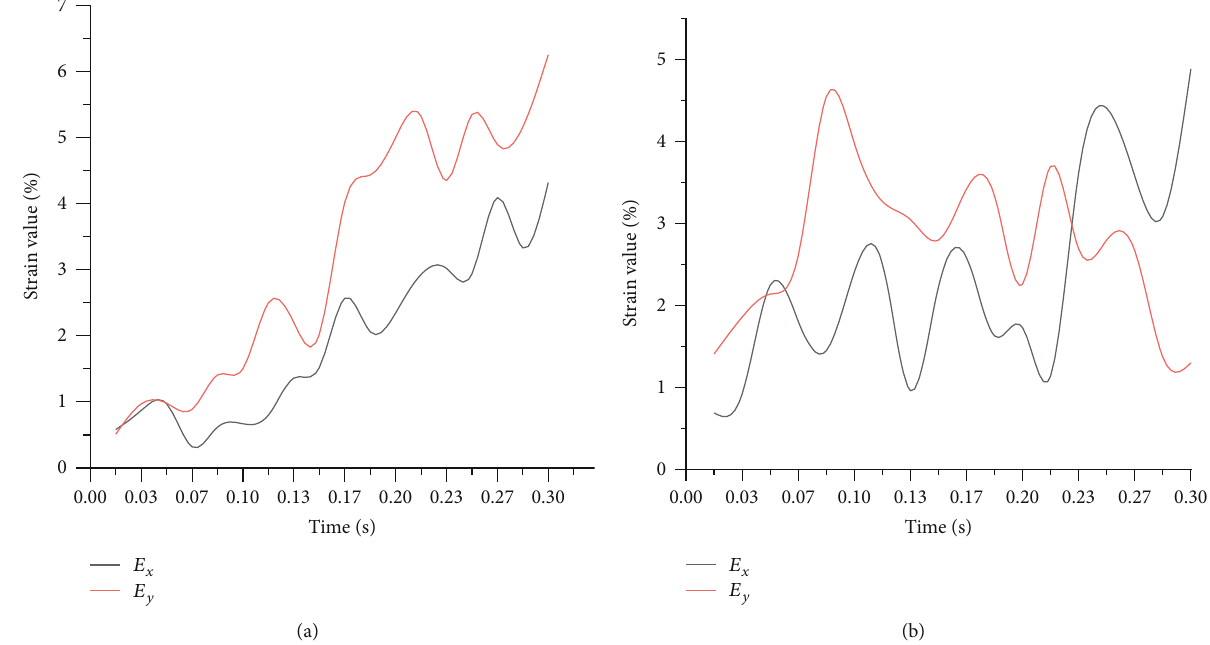
Figure 4: Distribution of strain values in X and Y directions in the (a) 3 rd toe pad area and (b) palm pad